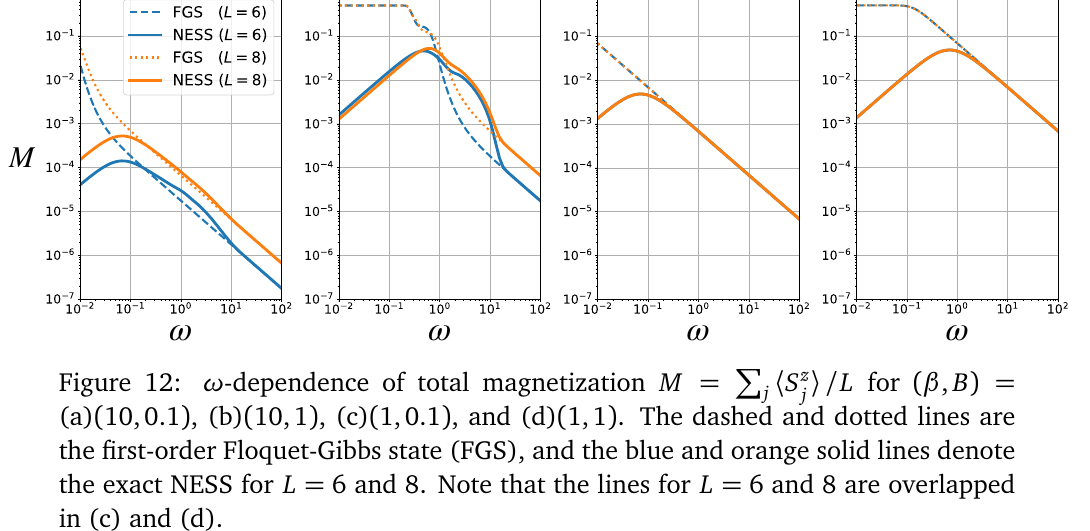
(cid:80) 〈 S z 〉 / L for ( β , B ) = j j